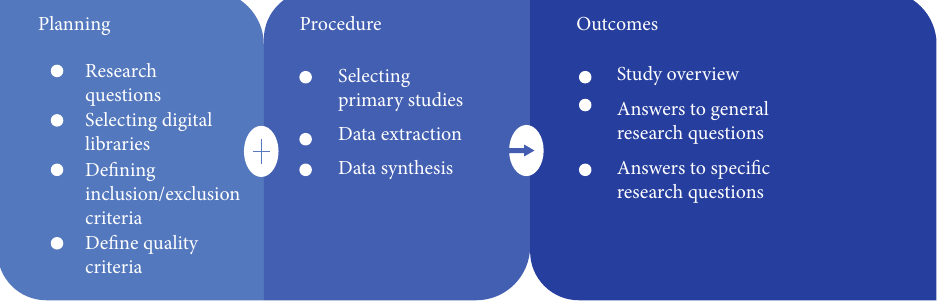
Figure 2: SRL overview